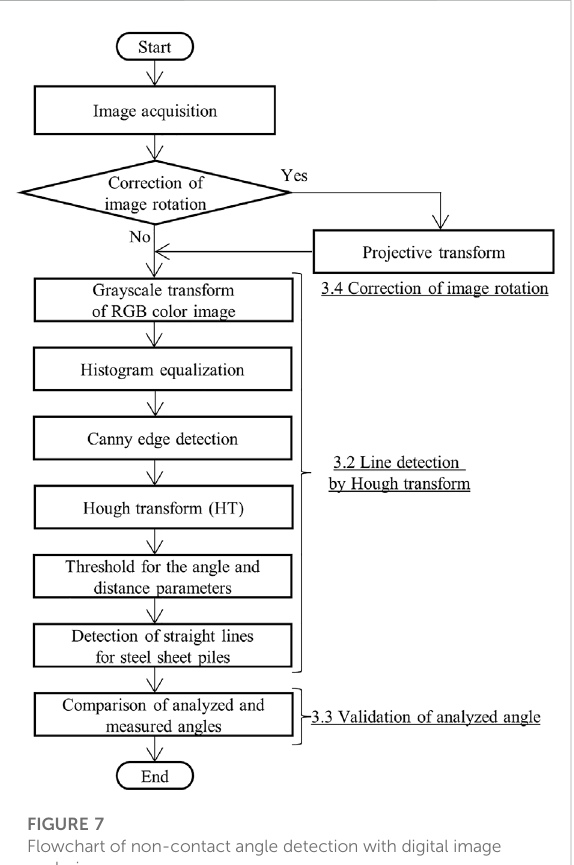
FIGURE 7 Flowchart of non-contact angle detection with digital image